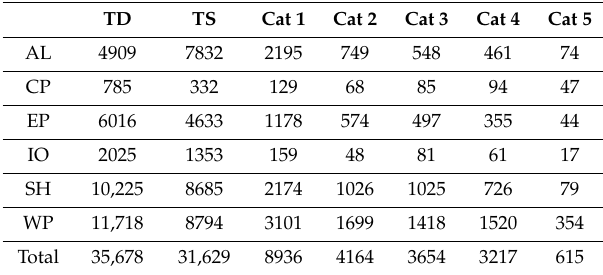
Table 1. Total observations from satellite passive microwave (PMW) sensors in 1987–2012 for every tropical cyclone (TC) basin and category.